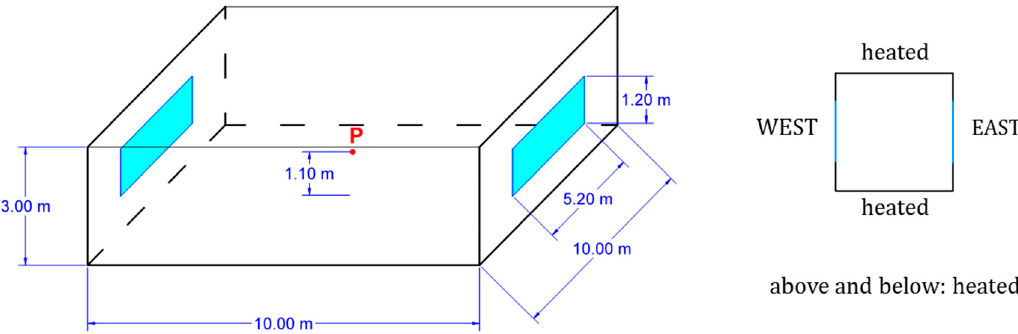
Figure 2. The simulated room considered as case study.